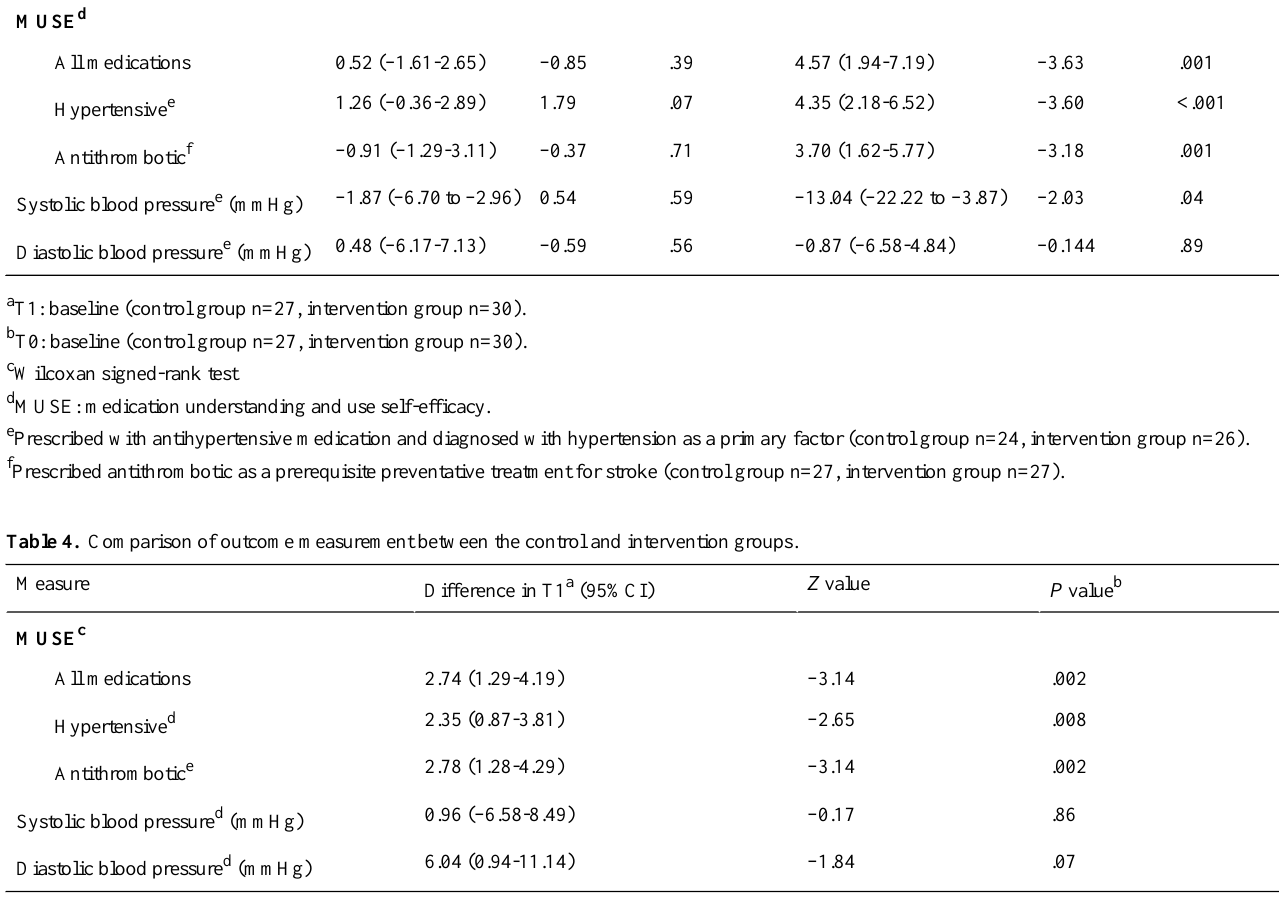
Intervention groupControl groupMeasure